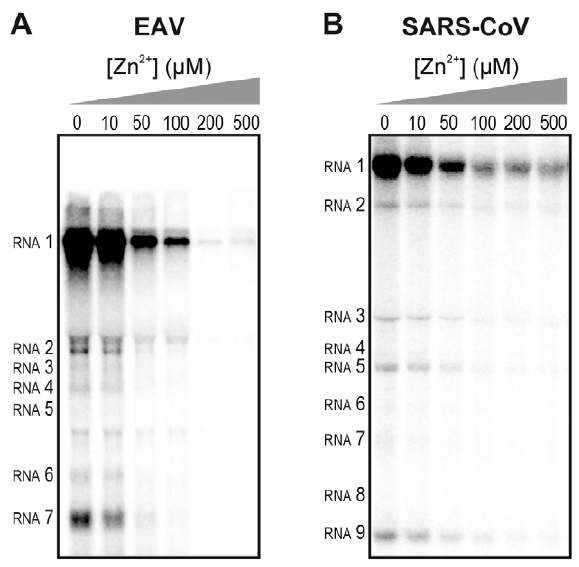
Figure 2. Inhibition of the invitro RNA-synthesizing activity of isolated RTCs by Zn 2 + . Incorporation of [ a - 32 P]CMP into viral RNA by EAV ( A ) and SARS-CoV ( B ) in RTC assays in the presence of various Zn 2 + concentrations, as indicated above each lane.